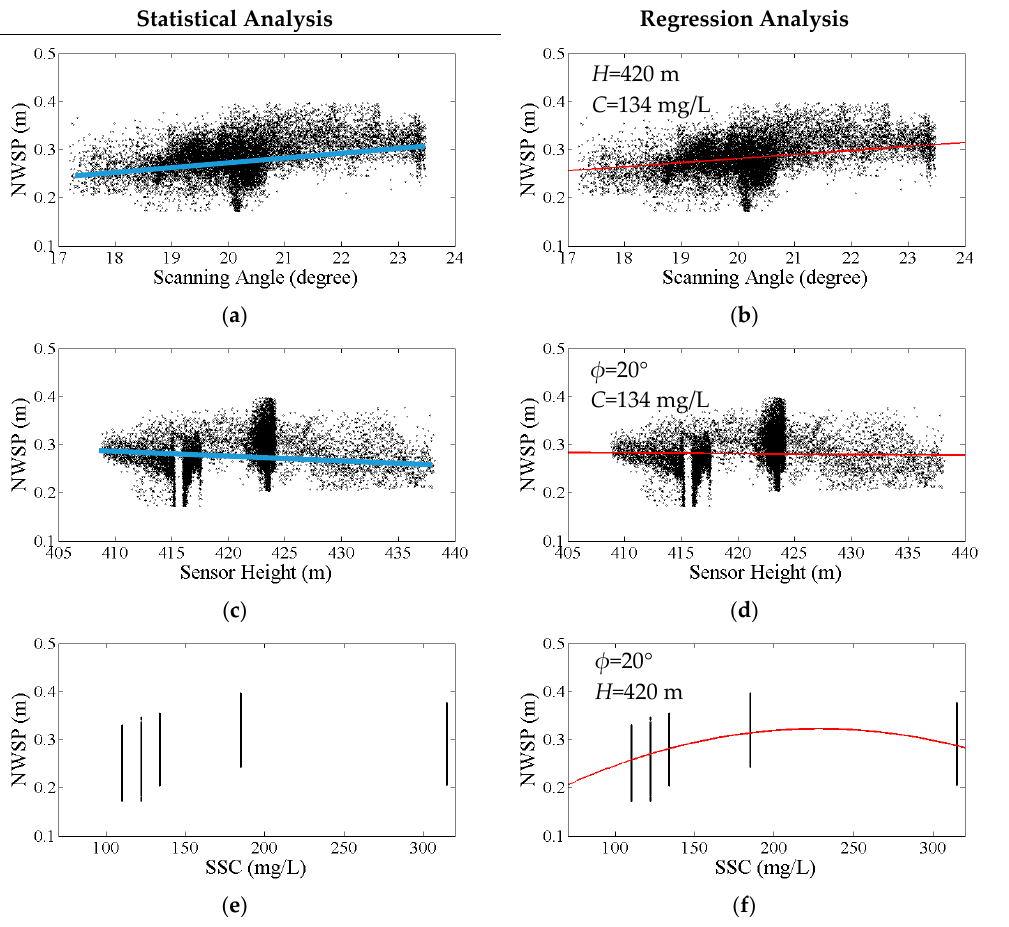
Figure 3. ( a – f ) Relationships of Δ d varying with φ , H , and C .